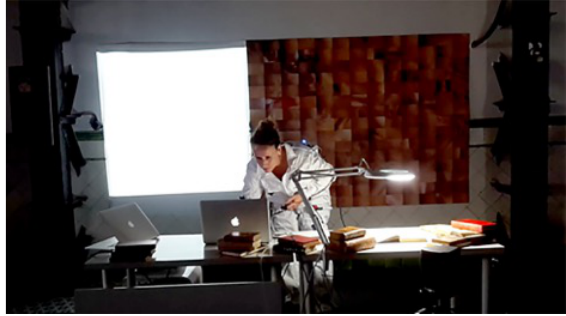
Figure 4 | Emerging Self Performance Festival FACTT Lisbon MATT. Source: the author,